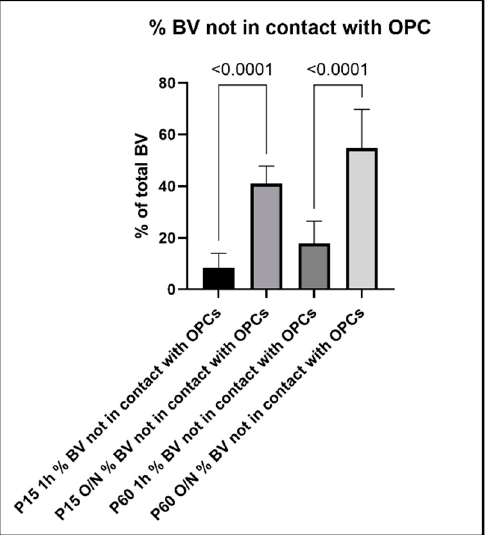
Figure 9. Percentage of blood vessels that are not in contact with OPCs and their protrusions.